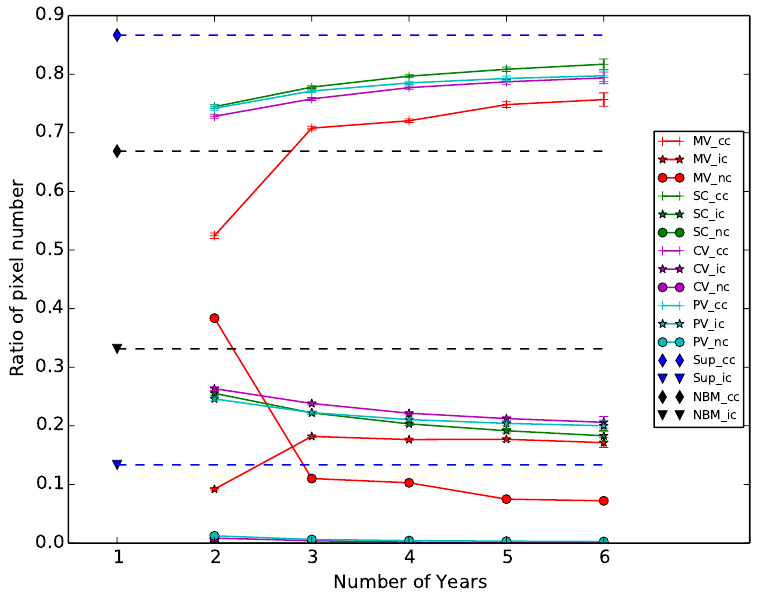
Figure 7. Pixel distribution for each method and different size of history. For each method, we plotted the ratio of correctly classified (cc), incorrectly classified (ic) and undecided, i.e., not classified (nc). The dashed lines represent the limits defined by the standard supervised and naive